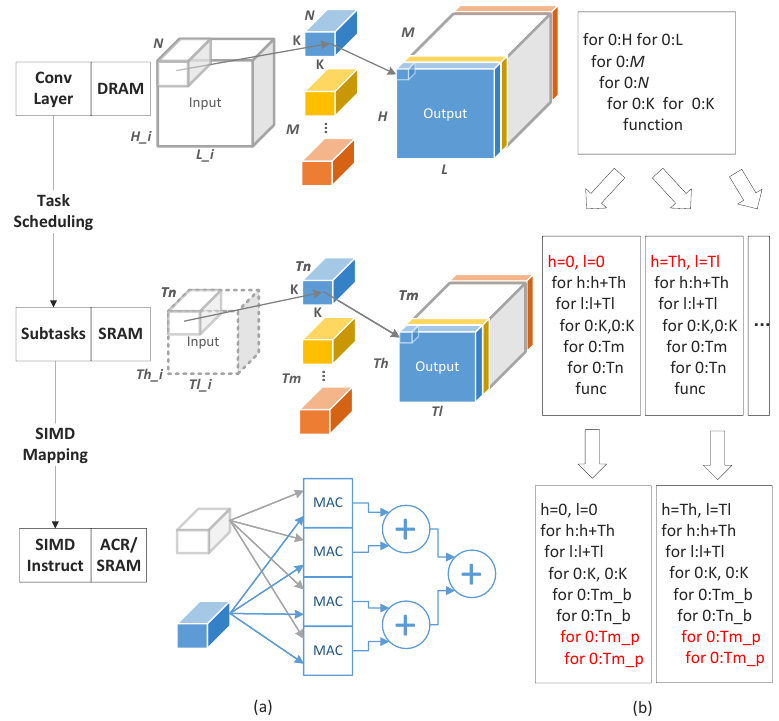
Figure 9. Mapping of convolution layer. ( a ) Mapping from convolution layer to DLPs. ( b ) Corre- sponding